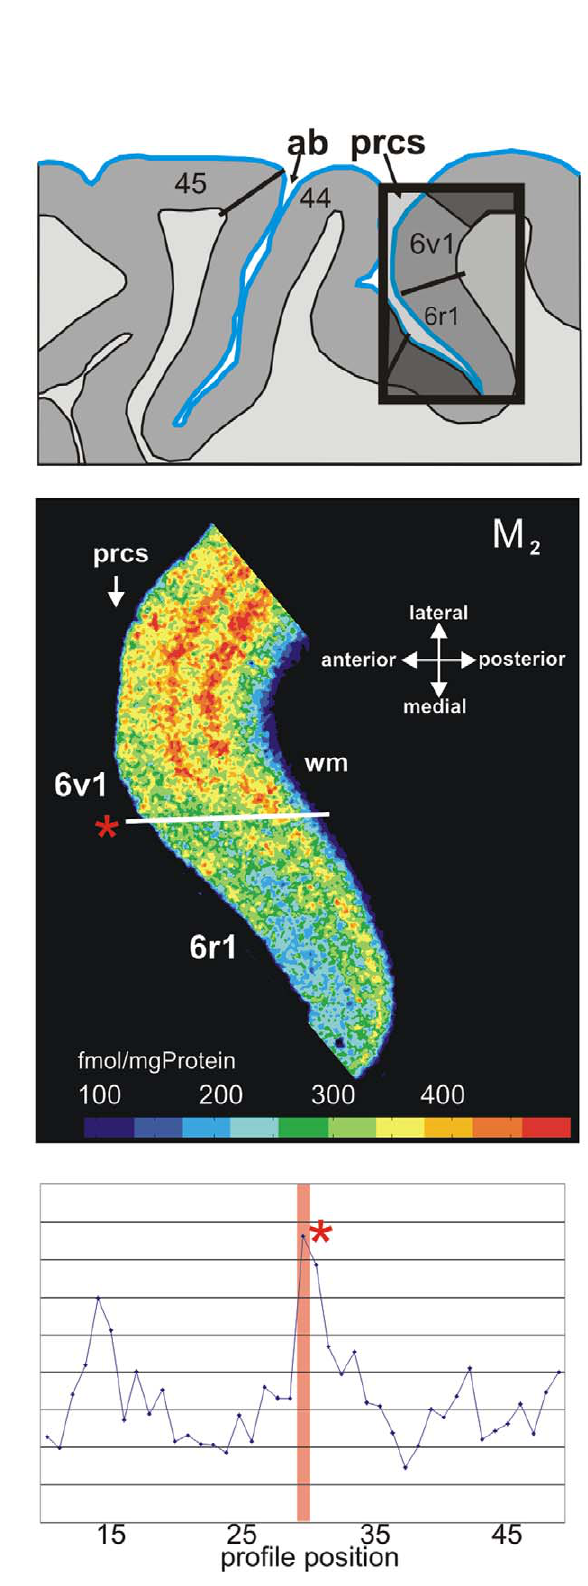
Figure 6. Receptor architectonic borders of area 6r1 with area 6v1 based on cholinergic M 2 -receptor distribution. Demonstra- tion of the border (*) in a horizontal section of the posterior wall of the precentral sulcus and location of the ROI. The border between area 6v1 and area 6r1 is characterized by a decrease of M 2 receptor density. prcs, precentral sulcus; wm, white matter. The graphs demonstrate quantification of borders. Designation as above.